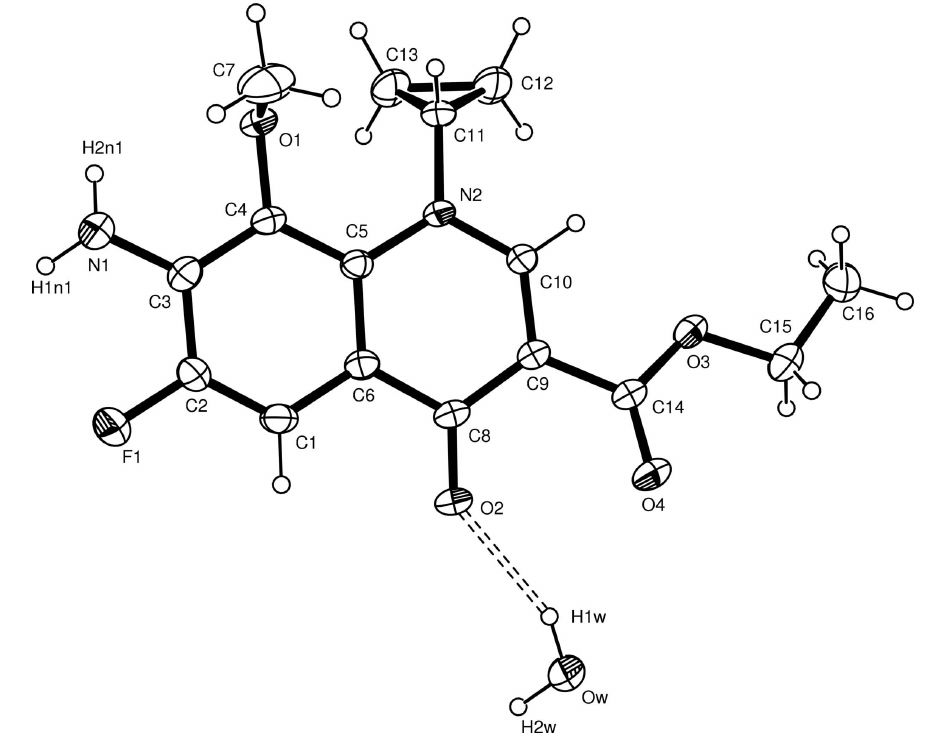
Figure 1 The molecular structure of the title compound, showing the atomic numbering scheme. Displacement ellipsoids drawn at the 30% probability level. The dashed line indicates a hydrogen bond.